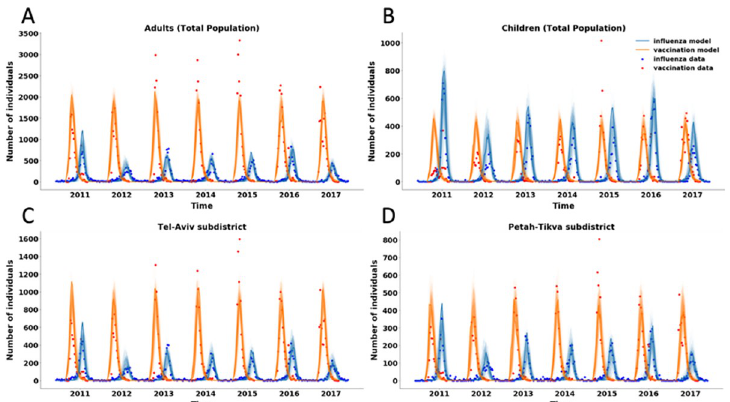
Fig 2. Time series of medical data vs. model fit. Weekly influenza vaccination uptake and influenza cases (dots(, and model fit (lines) between 2010–2017 for children < 18 years and adults > 18 years (A, B) and in two central subdistricts in Israel (C, D) (see S4 and S5 Figs in the S1 Appendix for the model’s fit for other subdistricts).